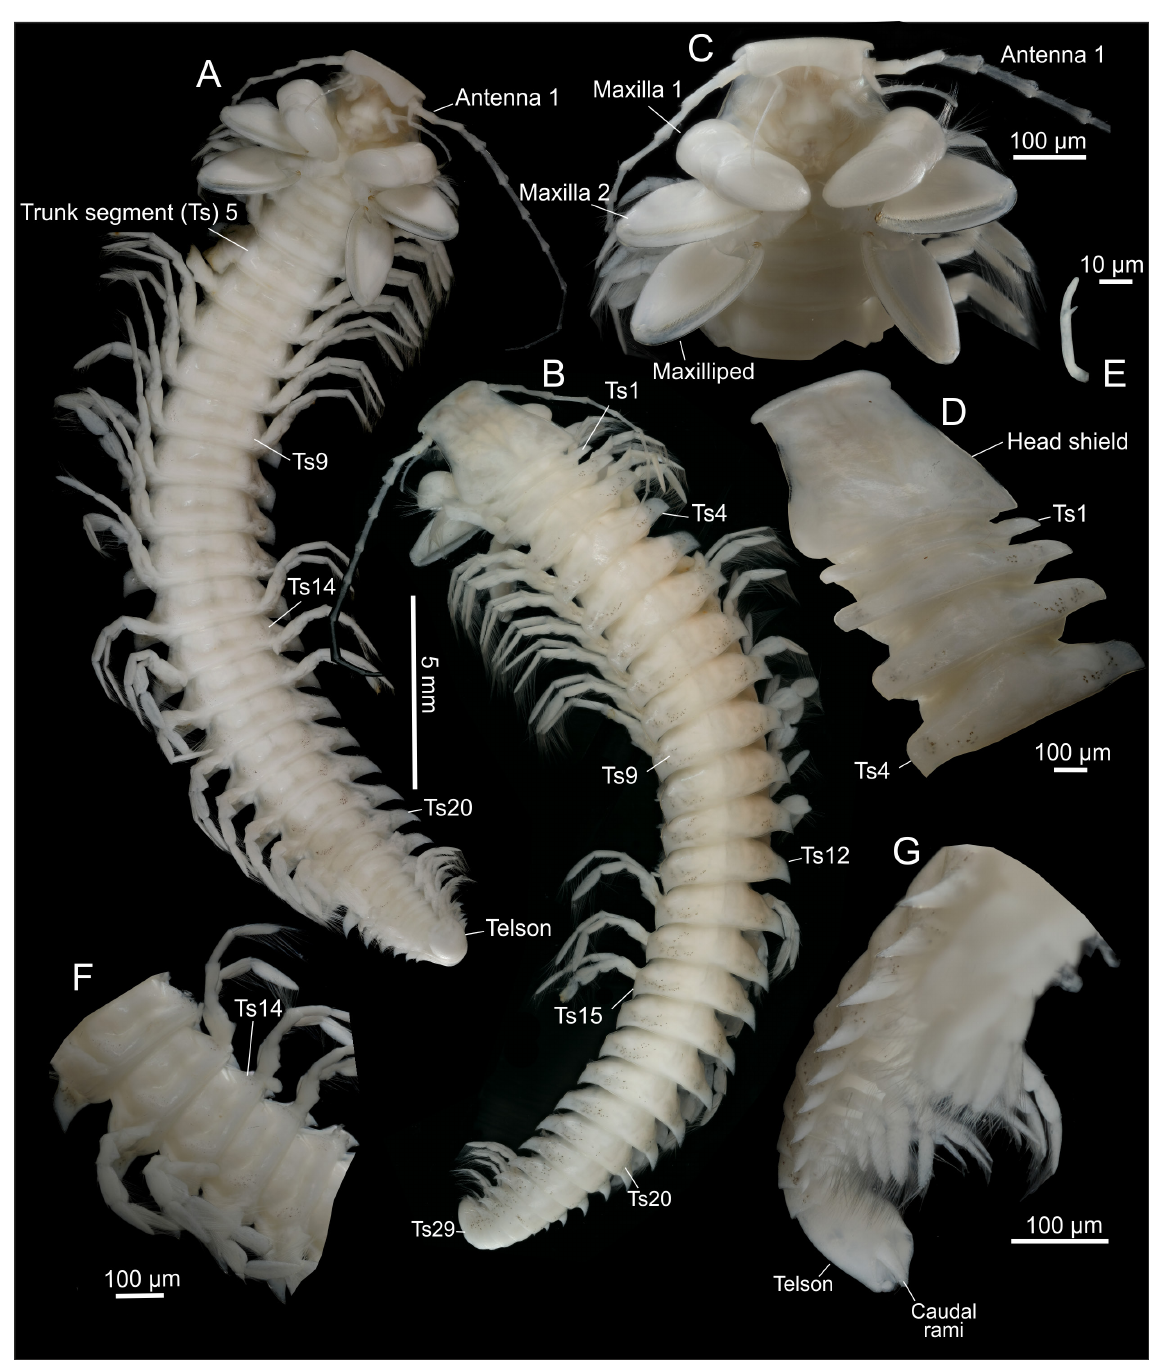
Fig. 3. Godzillius louriei sp. nov., holotype (NHMD 669698), light microscopy. A . Entire animal, ventral view. B . Entire animal, dorsal view. C . Cephalon, ventral view. D . Cephalon, dorsal view. E . Frontal filament, left side. F . Sternal bars and trunk segments (Ts), ventral view. G . Telson, lateral